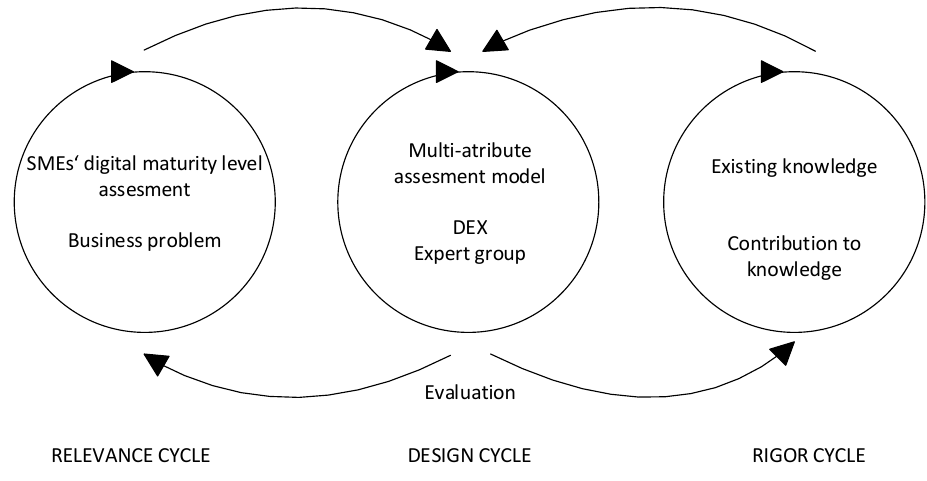
Figure 1. Research approach.